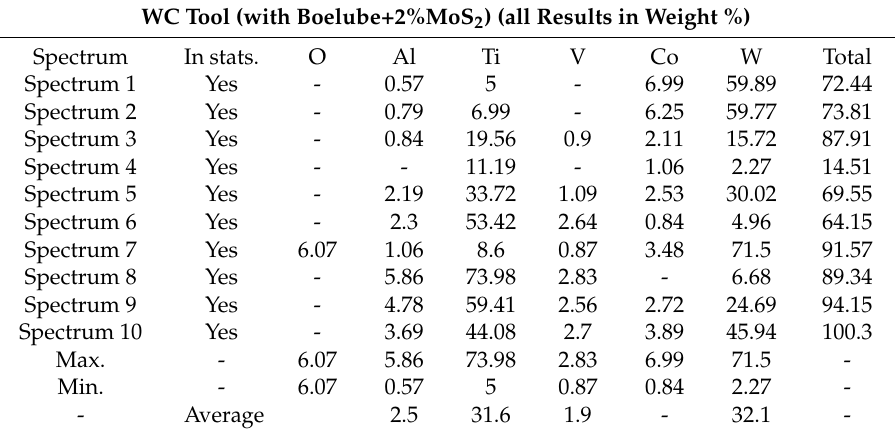
Table 4. Elemental analysis of surface of the edge of a WC tool cutting Ti with Boelube+2%MoS 2 .